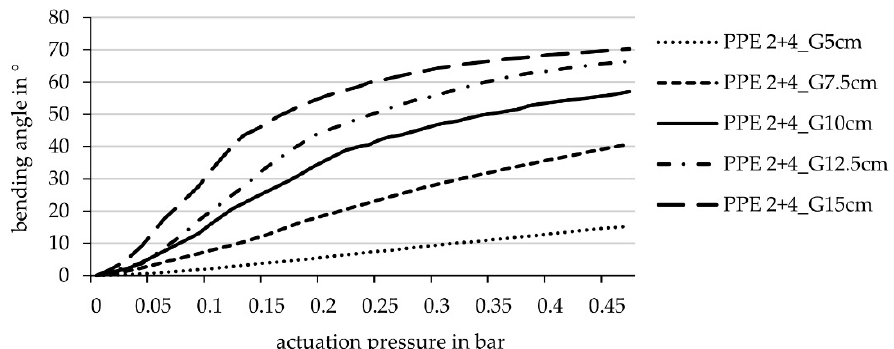
Figure 10. Achievable bending angle (simulation) in relation to the actuation pressure for laminate set-ups with different hinge widths: 5 cm, 7.5 cm, 10 cm, 12.5 cm, 15 cm (laminate set-up PPE 2 + 4 cf. Figure 1 equal for all samples).